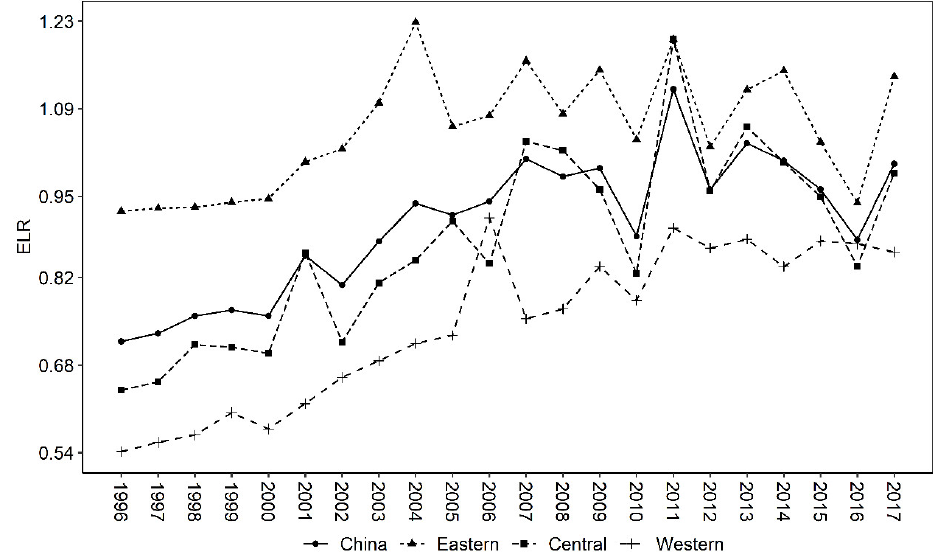
Figure 3. Trends in China’s agricultural ELR, 1996–2017.